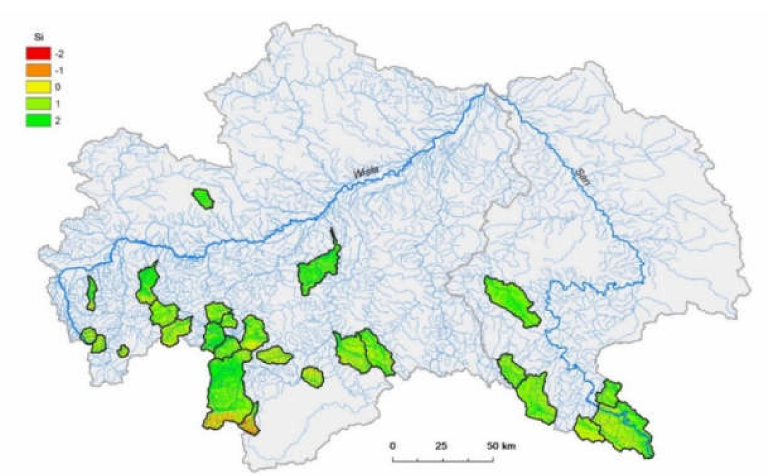
Figure 5. Soil texture ( Ss ) of analyzed catchments in the Upper Vistula basin.